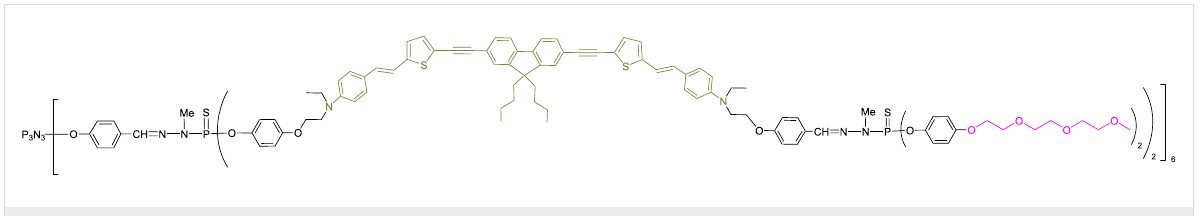
Figure 11: A fluorescent water-soluble dendrimer, applicable for two-photon photodynamic therapy and imaging.